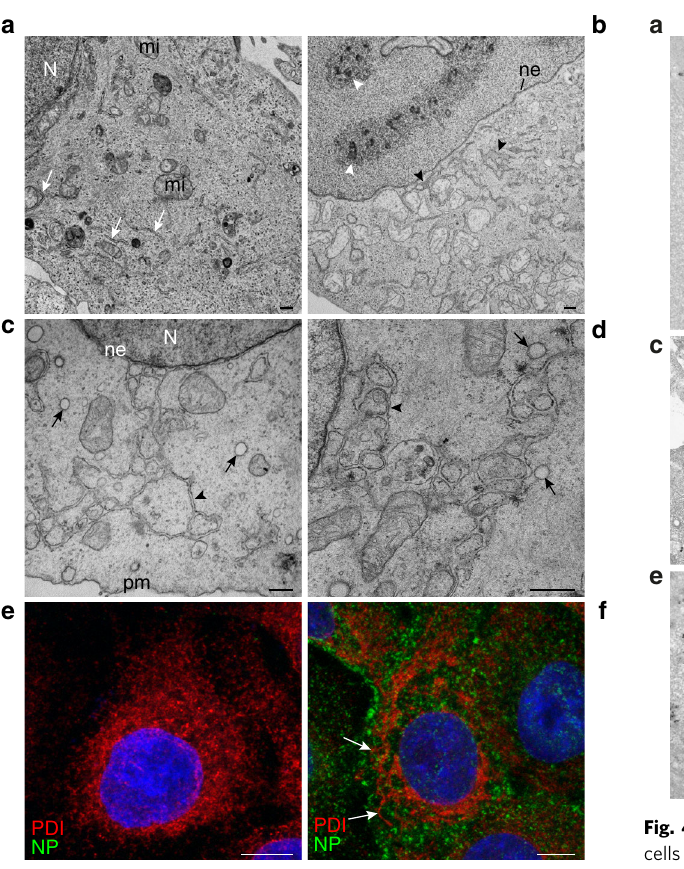
Fig. 3 Time-course of in fl uenza virus infection shows a progressive remodeling/tubulation of ER in A549 cells. a TEM of a mock-infected A549 cell. Mitochondria (mi) and rough endoplasmic reticulum (white arrows) have a random distribution. N, nucleus. b WSN-infected A549 cell at 4 hpi. The cell contains intranuclear dense structures (white arrowheads). Black arrowheads mark tubular, swollen ER membranes near the nuclear envelope (ne). c , d WSN-infected A549 cells at 6 hpi. Long ER-like tubular membranes (black arrowheads) expand from the nuclear envelope (ne) to the plasma membrane (pm). Arrows point to ICVs. e , f Immuno fl uorescence and confocal microscopy images showing viral NP (green) and the ER marker PDI (red) in mock- and WSN-infected A549 cells, respectively. Swollen/tubulated ER expands from the nucleus in WSN-infected cells at 8 hpi (arrows in f ). Scale bars, 0.5 μ m a − d ; 10 μ m e , f